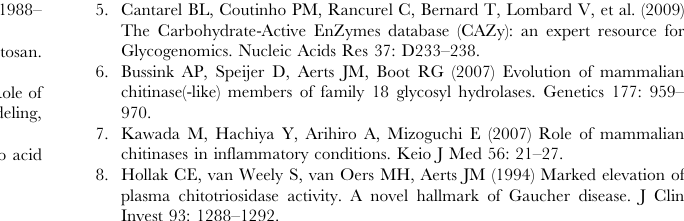
Figure S1 Deduced amino acid sequences and their theoretical molecular masses of pre-AMCase-V5-His and mature-AMCase-V5-His. The amino acid sequences are color coded, consistent with Figure 1A. Blue, signal sequence of mouse AMCase; Pink, mouse mature AMCase; Green, V5-His sequence. Figure S2 Deduced amino acid sequences and their molecular masses of recombinant proteins expressed in E. coli . The amino acid sequences are color coded, consistent with Figure 1B and 1C. Rich blue, signal sequence of Protein A; Yellow, truncated form of Protein A; Pink, mouse mature AMCase; Green, V5-His sequence. Table S1 Forward and reverse primers used to con- struct the mammalian and E. coli -expression vectors. Table S2 Effect of omission of the second osmotic shock on the distribution of chitinolytic activity. The recombi- nant protein was prepared from 0.5 L culture of E. coli. The periplasmic space 2/lysozyme fraction (Peri 2) was prepared as described in Materials and Methods without the second osmotic shock. The preparations were performed in